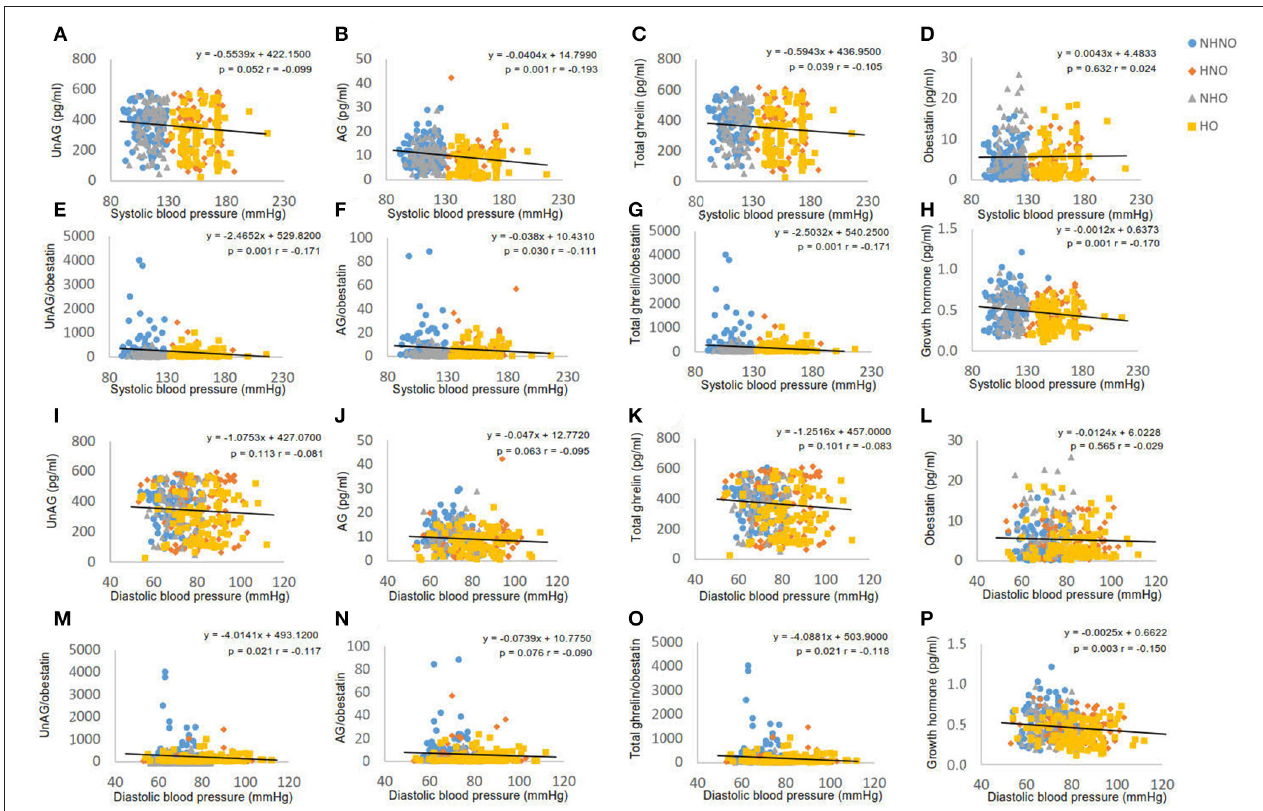
FIGURE 2 | Correlation analyses of blood pressure to ghrelin gene products, growth hormone and ratios of two forms of ghrelin to obestatin. (A) Correlation between systolic blood pressure and serum level of unacylated ghrelin. (B) Correlation between systolic blood pressure and serum level of acylated ghrelin. (C) Correlation between systolic blood pressure and serum level of total ghrelin. (D) Correlation between systolic blood pressure and serum level of obestatin. (E) Correlation between systolic blood pressure and the ratio of unacylated ghrelin to obestatin in serum. (F) Correlation between systolic blood pressure and the ratio of acylated ghrelin to obestatin in serum. (G) Correlation between systolic blood pressure and the ratio of total ghrelin to obestatin in serum. (H) Correlation between systolic blood pressure and serum level of growth hormone. (I) Correlation between diastolic blood pressure and serum level of unacylated ghrelin. (J) Correlation between diastolic blood pressure and serum level of acylated ghrelin. (K) Correlation between diastolic blood pressure and serum level of total ghrelin. (L) Correlation between diastolic blood pressure and serum level of obestatin. (M) Correlation between diastolic blood pressure and the ratio of unacylated ghrelin to obestatin in serum. (N) Correlation between diastolic blood pressure and the ratio of acylated ghrelin to obestatin in serum. (O) Correlation between diastolic blood pressure and the ratio of total ghrelin to obestatin in serum. (P) Correlation between diastolic blood pressure and serum level of growth hormone. Pearson’s correlation analyses were performed. Statistical significance was accepted at p < 0.05. Circle refers to the data of non-hypertensive non-centrally obese subjects. Rhombus refers to the data of hypertensive non-centrally obese subjects. Triangle refers to the data of non-hypertensive centrally obese subjects. Square refers to the data of hypertensive centrally obese